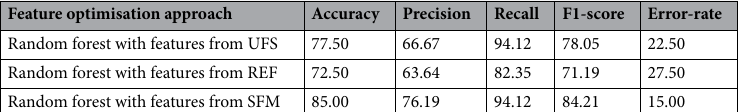
Feature optimisation